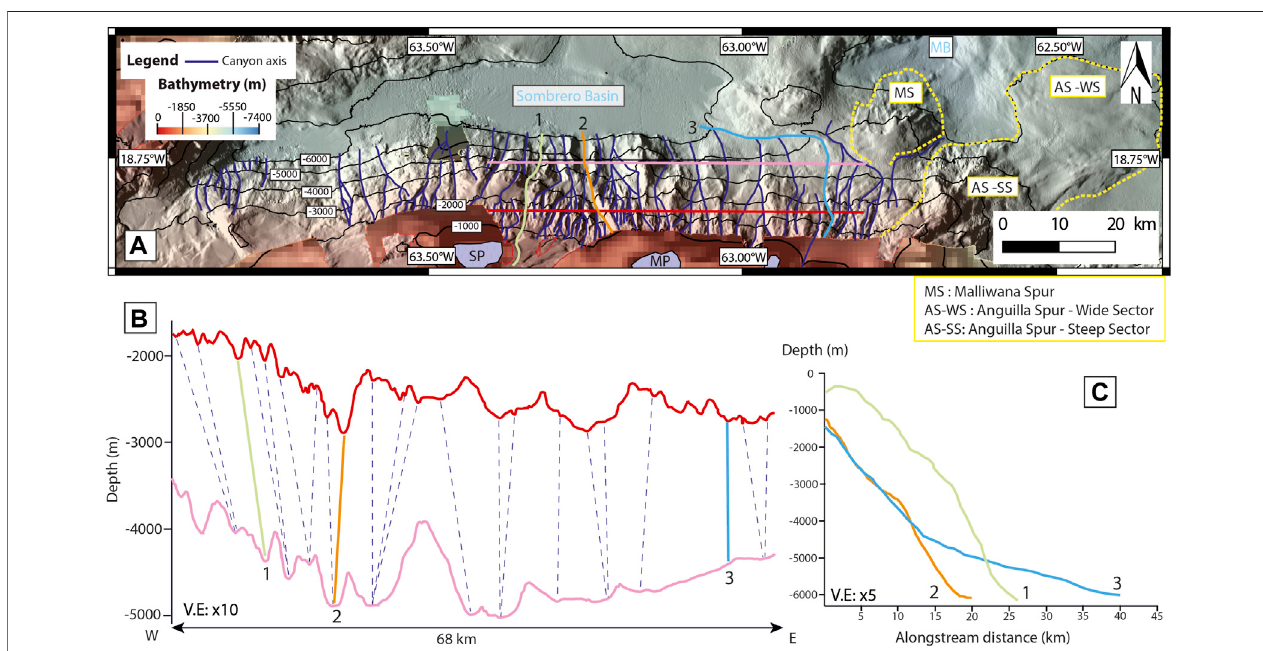
FIGURE 6 | (A) Enlargement of the Sombrero Escarpment. MB: Malliwana Basin, MP: Malliwana Platform, SP: Sombrero Platform. (B) W-E cross-section of the Sombrero Escarpment. The red cross-section is between 1,700 and 2,900 m and the lightpink cross-section isbetween 3,500 and 5,100 m. Blue dots followcanyons axis between the two cross-sections. Three canyons axis (1, 2, and 3) are represented and referred to Figure 6C . (C) Bathymetric pro fi les of three canyons axis (1, 2, and 3).